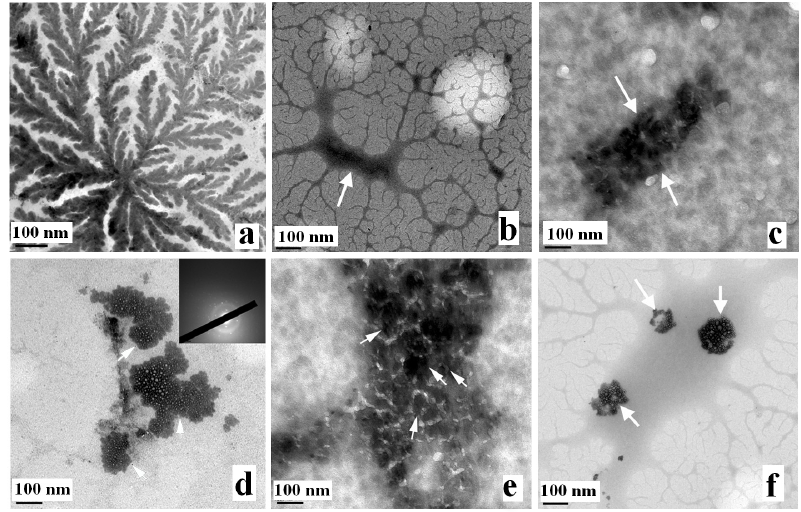
Figure 4. TEM images of KG and KG-metal complexes, indicating the formation of nanostructures. ( a ) pure KG (1.0 mg L − 1 ); ( b ) KG-Cd complex; ( c ) KG-Pb complex; ( d ) KG-Ni complex; ( e ) KG-Fe complex; ( f ) KG-Cr complex.